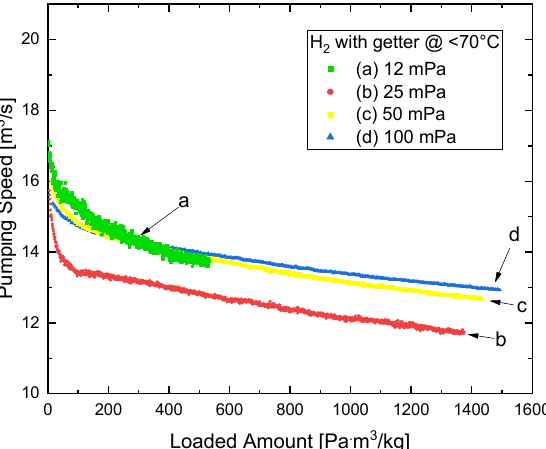
nificant only for pressures > 50 mPa.